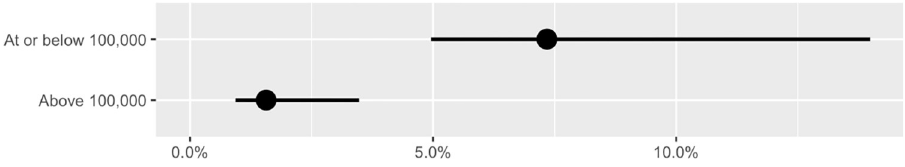
Fig 4. Estimated anti-SARS-CoV-2 seroprevalence across income categories in King County in early-to-mid- August 2020. Income categories in United States dollars. Points indicate estimates and lines indicate 95% confidence